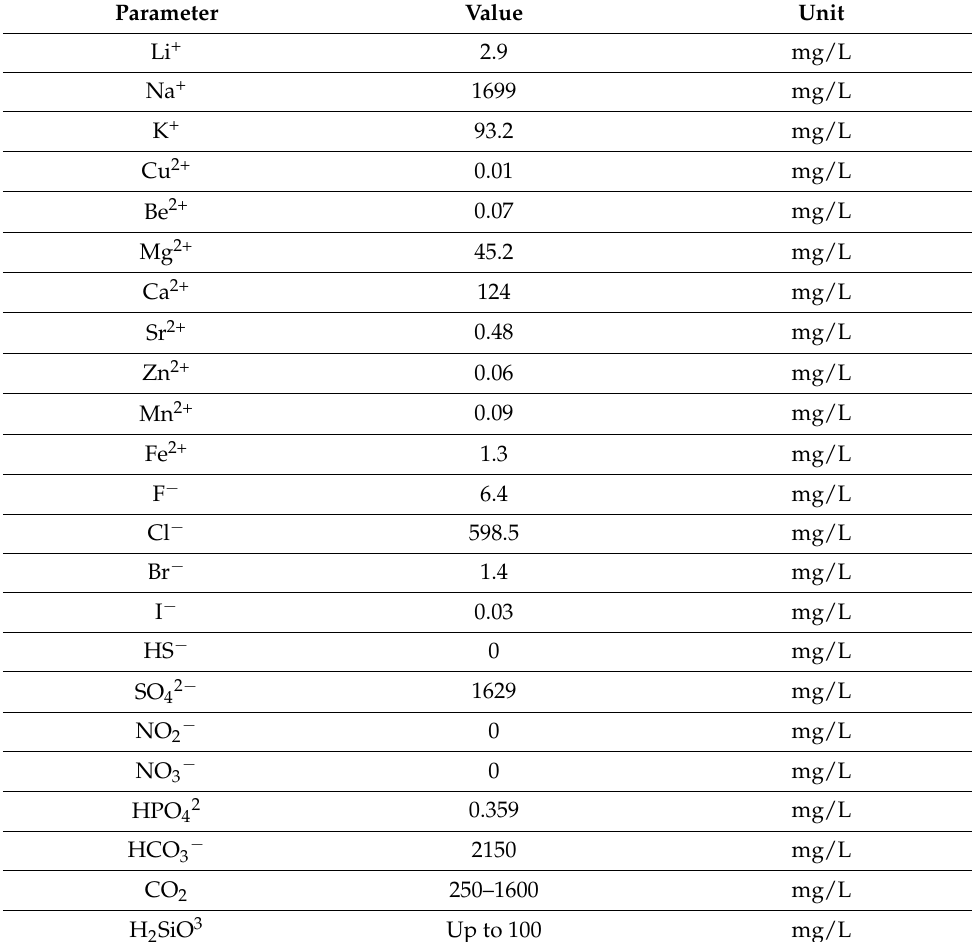
Table 1. Chemical composition of Carlsbad hot spring water